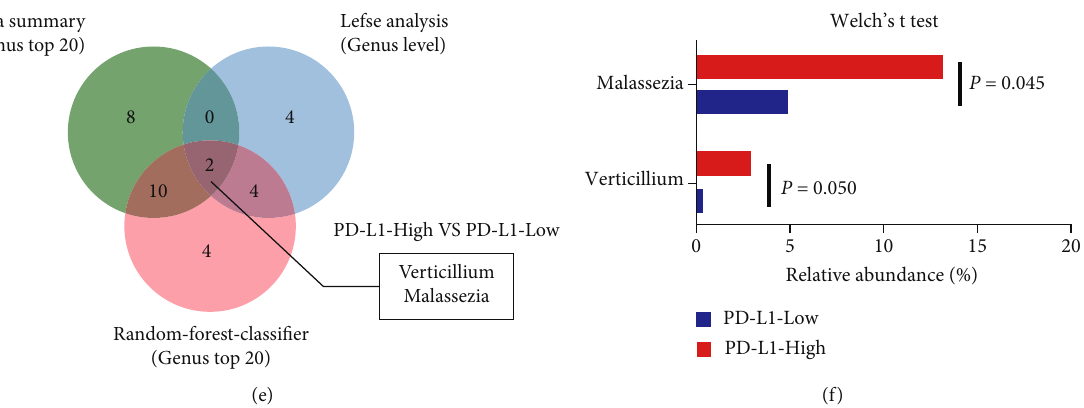
Figure 2: The fungal microbiota composition in the di ff erent PD-L1 expression groups. (a) Cladogram representation between the PD-L1- High and PD-L1-Low group. (b) Histogram of the linear discriminant analysis (LDA) scores. (c) The random-forest-classi fi er analysis. (d) The taxa summary analysis. (e) The Venn diagram. (f) Welch ’ s t test was used to analyze between the two